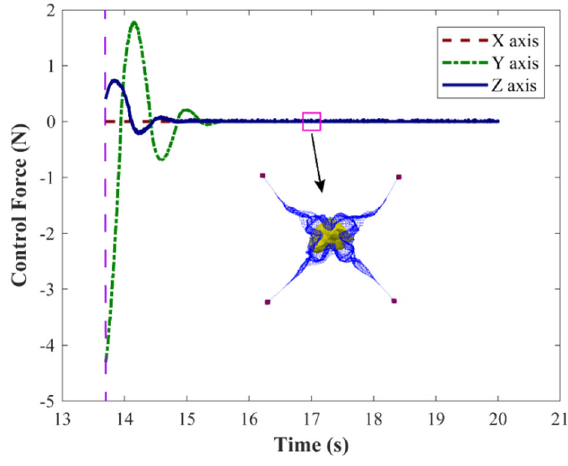
Figure 13. Contact forces during the capture and control process.